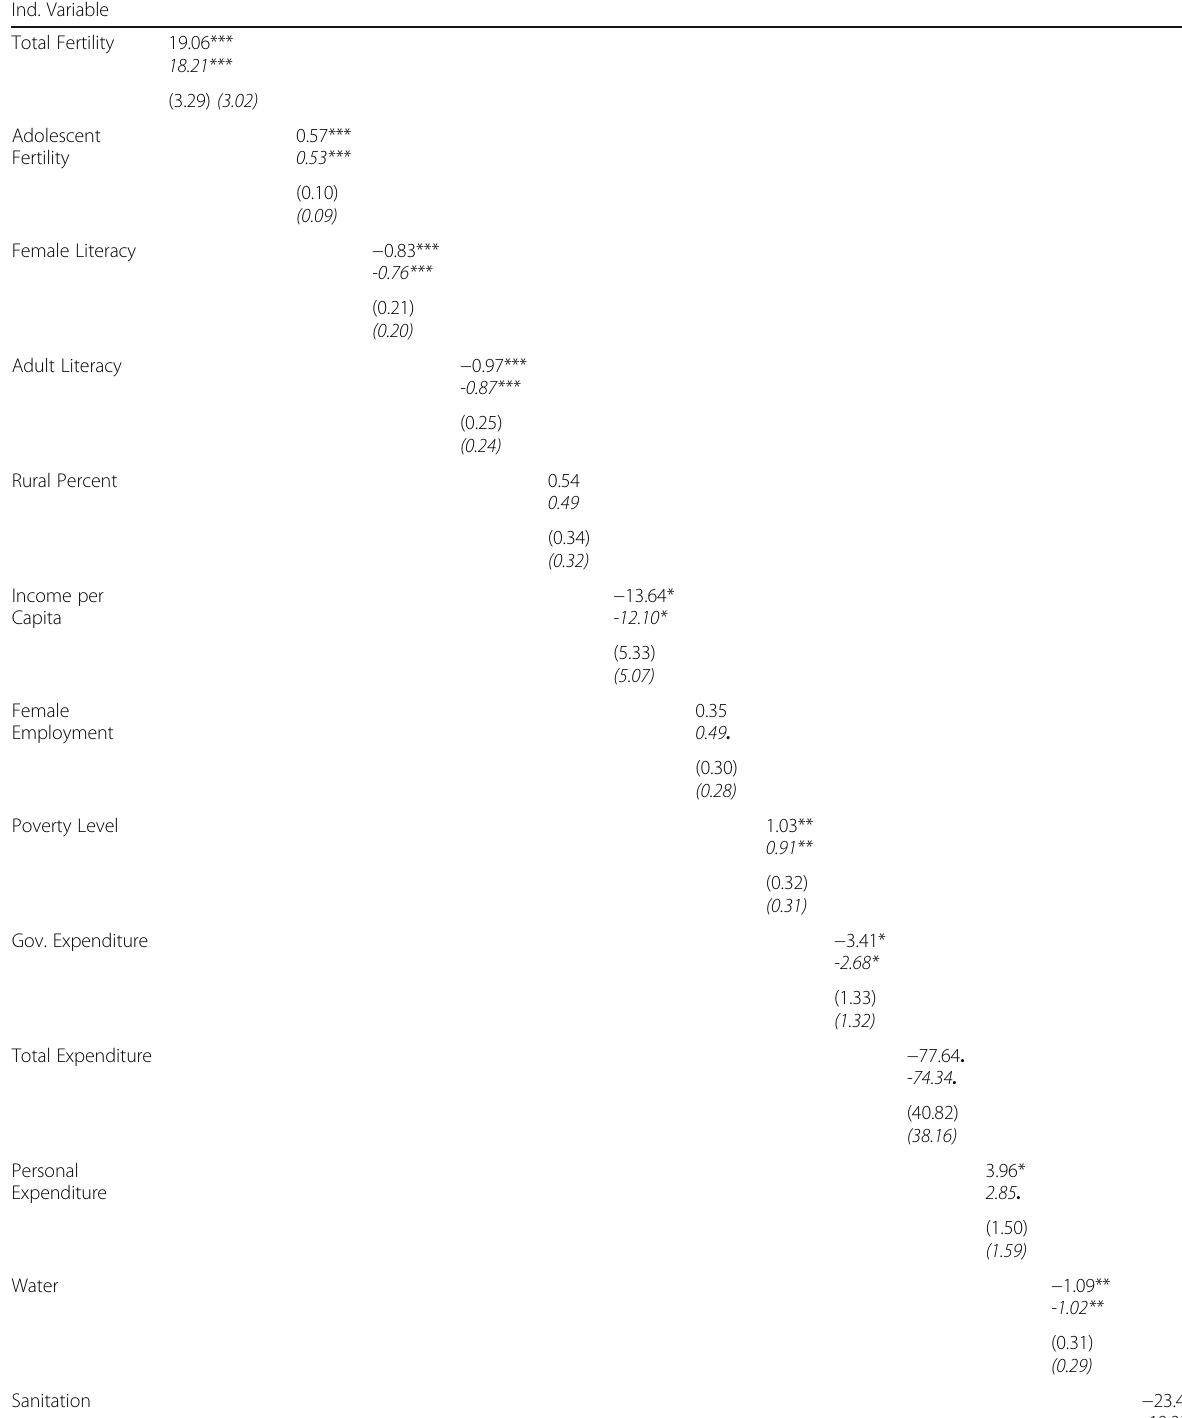
Table 4 Results for bivariate relationships between each IV and the DV Dependent Variable =